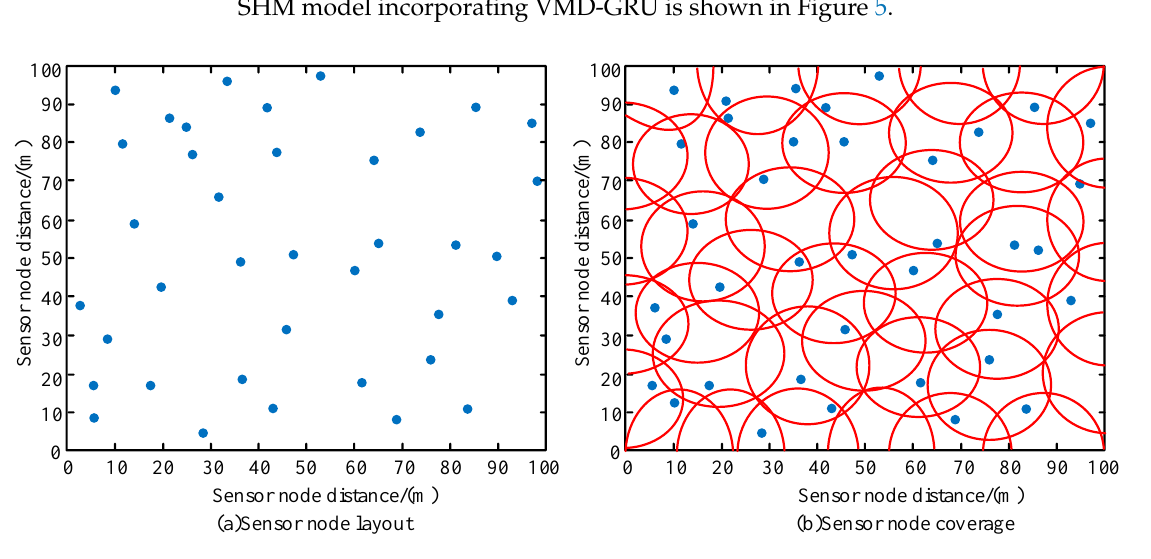
Figure 4. Placement and coverage of wireless sensor nodes based on probability perception.